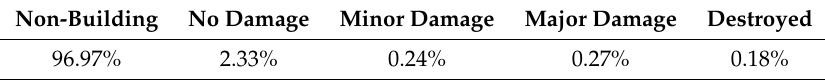
Table 2. Non-building Area and building area ratio in pixel